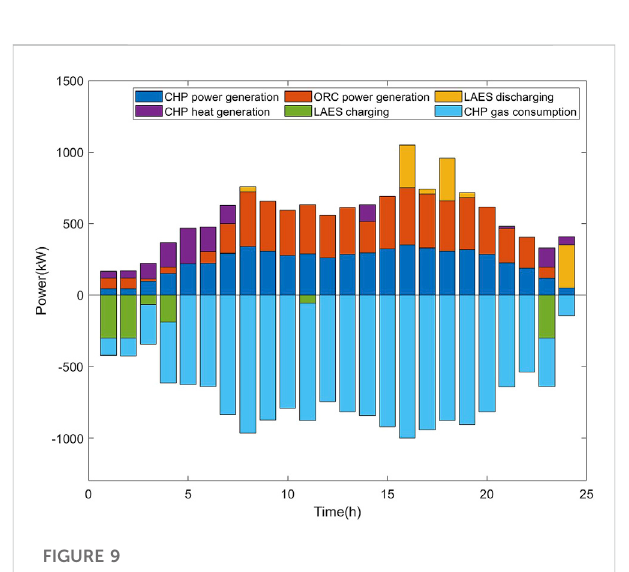
FIGURE 9 Input and output of LAES-ORC-CHP